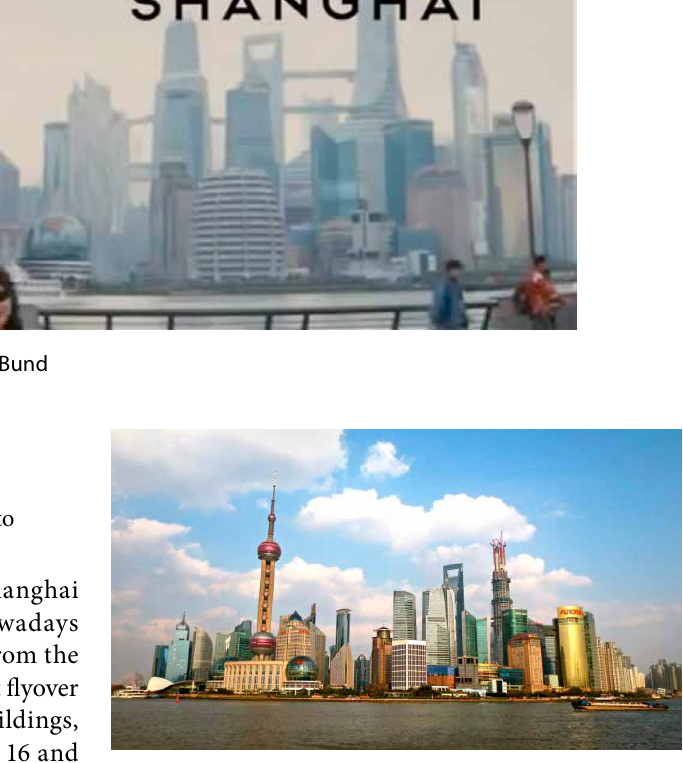
fig.17. actual view of Pudong from the